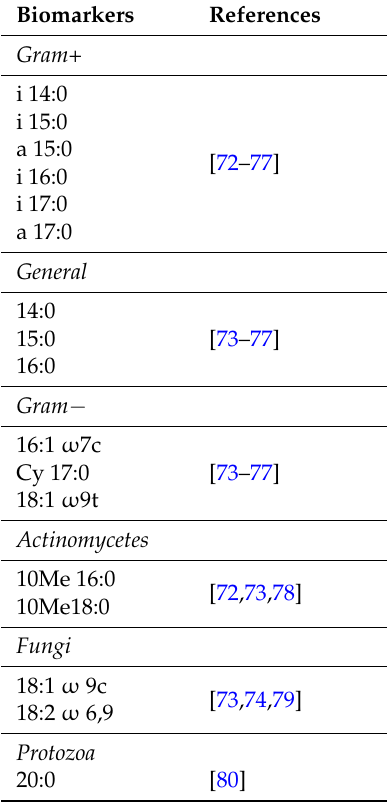
Table A3. Ester linked fatty acids (EL-FAMEs) signature assignment used in this study.